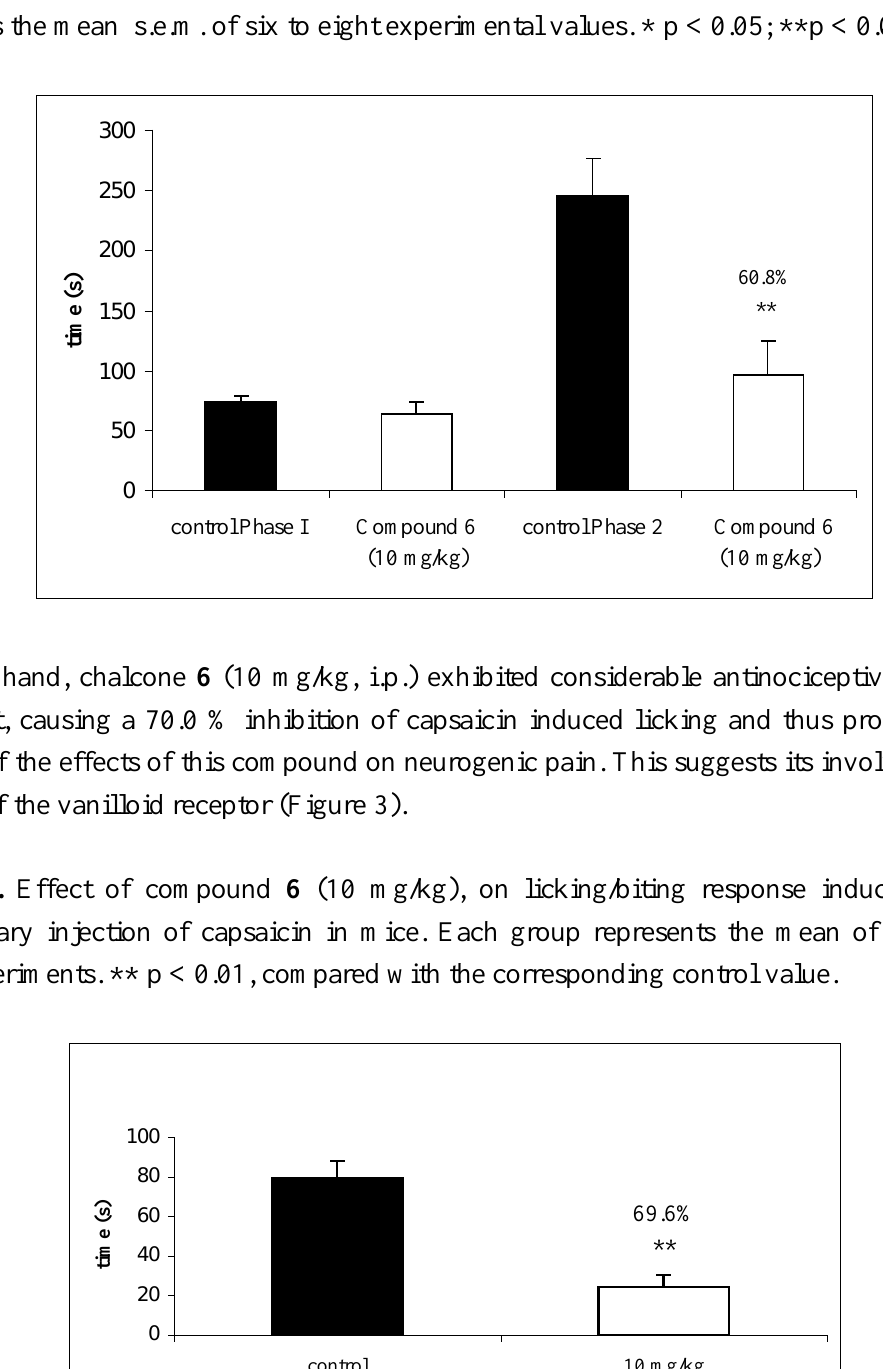
Figure 2. Effect of compound 6 (10 mg/kg), given intraperitoneally, against the first (0 to 5 min) and second (15 to 30 min) phases in a formalin test in mice. Each column represents the mean s.e.m. of six to eight experimental values. * p < 0.05; **p < 0.01.